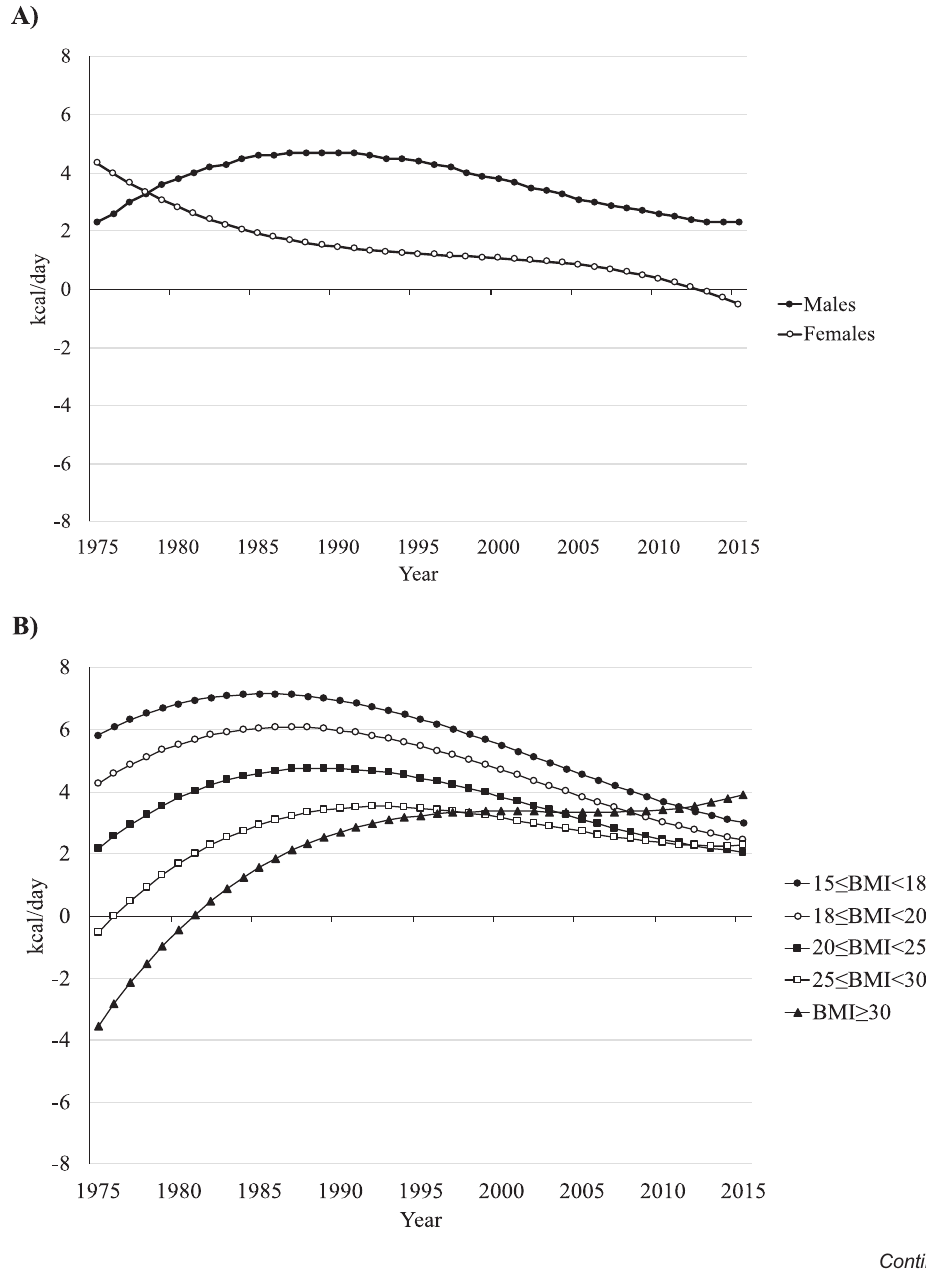
Table 1. Model parameters of the energy gap multiplier EIG for men ranged from − 3.5kcal = day for a BMI of ≥ 30.0 estimated through calibration, by sex, for Japanese kg = m 2 to 4.6 kcal = day for a BMI of 15.0 to 17.9kg = m 2 in 1975 adults aged 20 to 74 years, 1975 to (Figure 2B). The EIG increased for men with a BMI of 15.0 to 17.9 and 18.0 to 19.9kg = m 2 , peaking at 7.2 and 6.1kcal = day, respectively, in the mid to late 1980s and decreased to 3.0 and 2.5kcal = day, respectively, in 2015. A similar trend in the EIG was observed for men with a BMI of 20.0 to 24.9 and 25.0 to 29.9kg = m 2 , peaking at 4.8 and 3.5 kcal = day, respectively, in the late 1980s to early 1990s. The EIG for a BMI of ≥ 30.0 kg = m 2 continued increasing from 1975 to 2015.